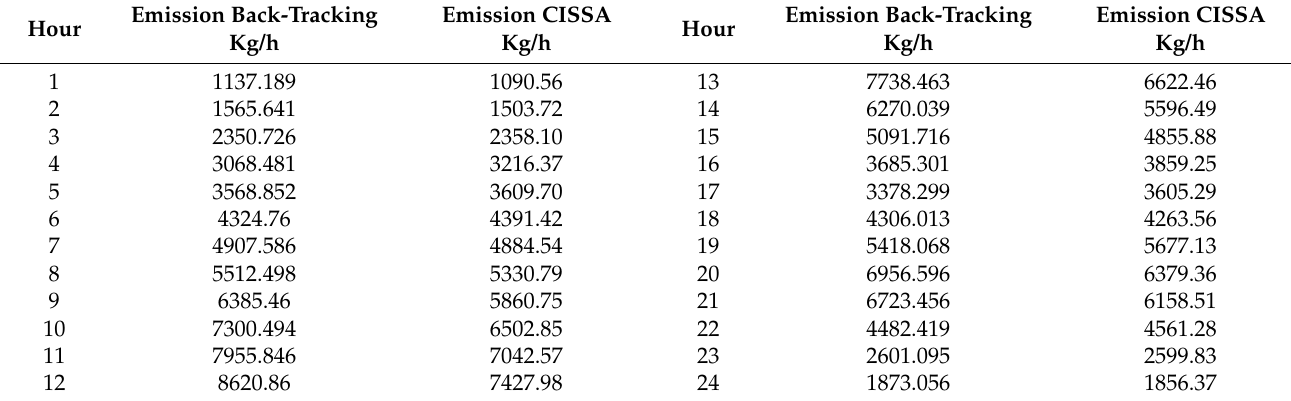
Table 30. Emissions comparison between CISSA and back-tracking.